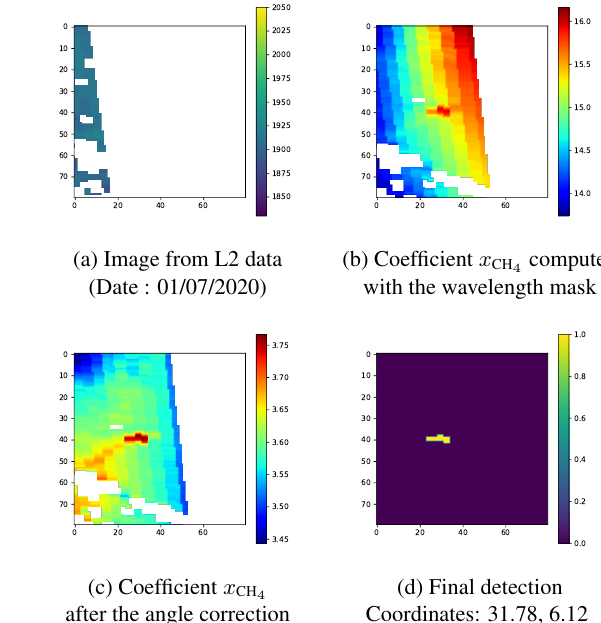
Figure 11. There is nearly no valid pixel available in the L2 data, as shown in Figure (a). However, by using the L1B data we are able to detect a plume, as shown in Figure